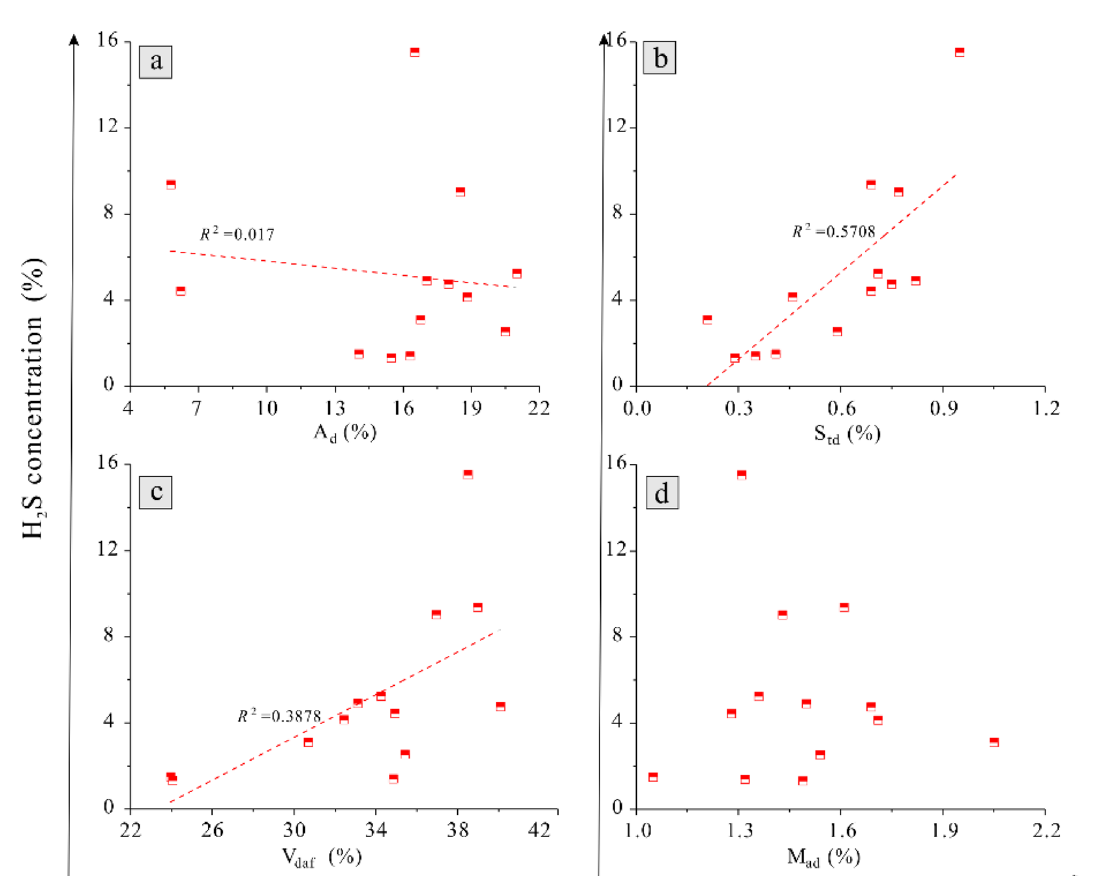
Figure 5. Correlation between coal quality and H 2 S concentration. ( a ) is the correlation of H 2 S concentration versus A d yield, ( b ) is the correlation of H 2 S concentration versus S td content, ( c ) is the correlation of H 2 S concentration versus V daf yield and ( d ) is the correlation of H 2 S concentration versus M ad